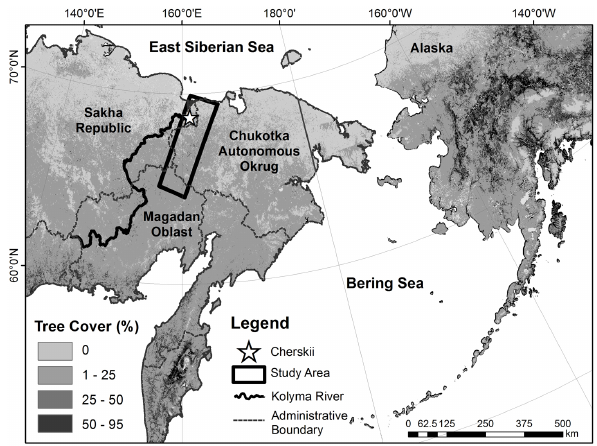
Fig. 1. Study area map of the lower Kolyma River watershed, which feeds into the East Siberian Sea in the Russian Far East. The study area spanned approximately 100000km 2 of open larch forest that transitioned into tundra along the northern